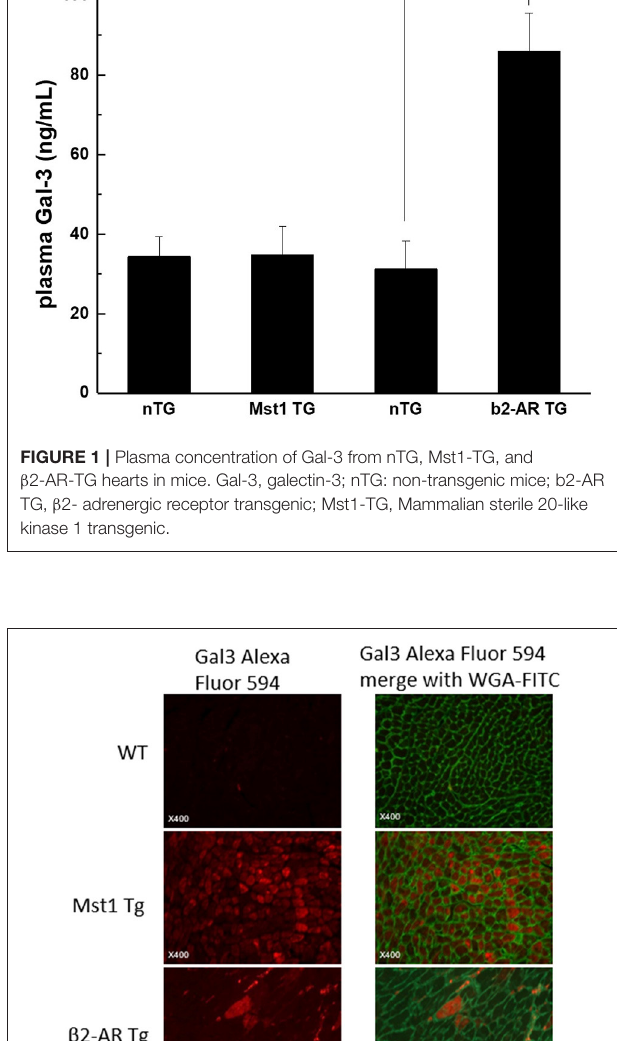
0.002), LVESD ( P = 0.036), LVESV ( P = 0.043), and LVEDV ( P =